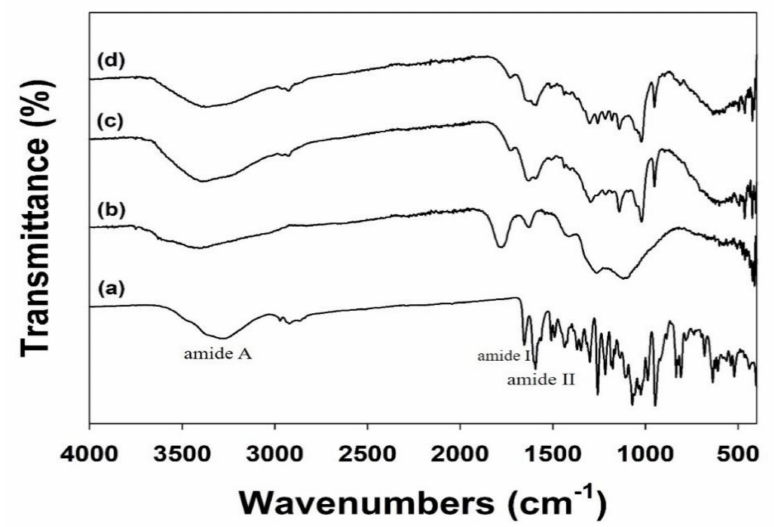
Figure 2. FTIR spectra of ( a ) ICA, ( b ) NDs, ( c ) ICA (10 µ g)-NDs, and ( d ) ICA (50 µ g)-NDs.